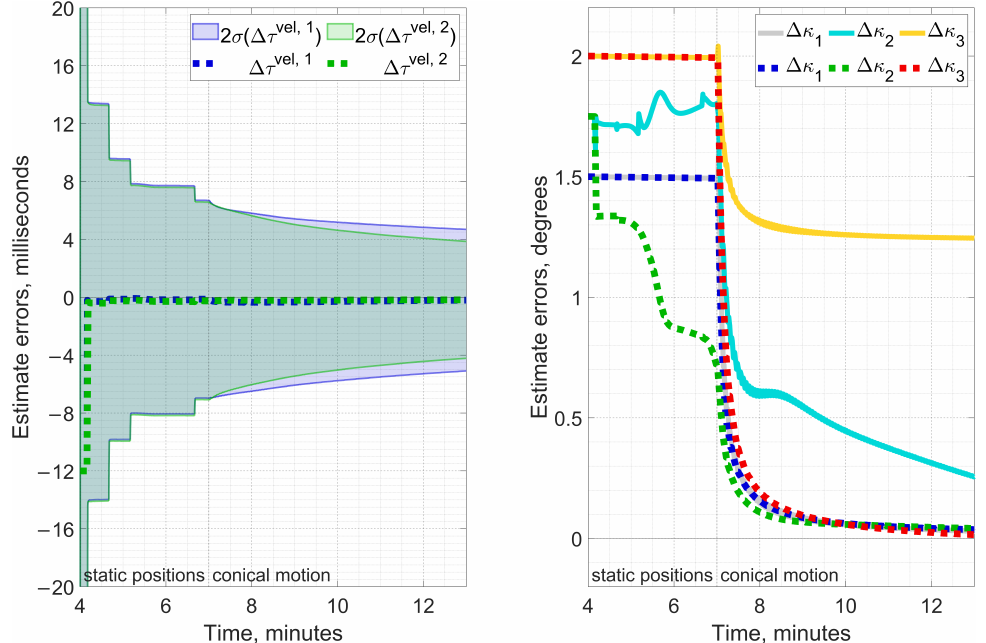
Figure 4. The left plot shows errors of τ vel ,1 , τ vel ,2 estimates (dashed lines) and their corresponding 2- σ intervals (semitransparent). The right plot contains errors of κ b estimates in two cases: with GNSS-derived velocity delays τ vel , k = 12 msec included in the estimation problem (dashed lines) and without them (solid lines). The latter have an κ 3 estimate converging to a wrong value and an κ 2 error decreasing much slower than it should. For a smaller magnitude of τ errors still may remain